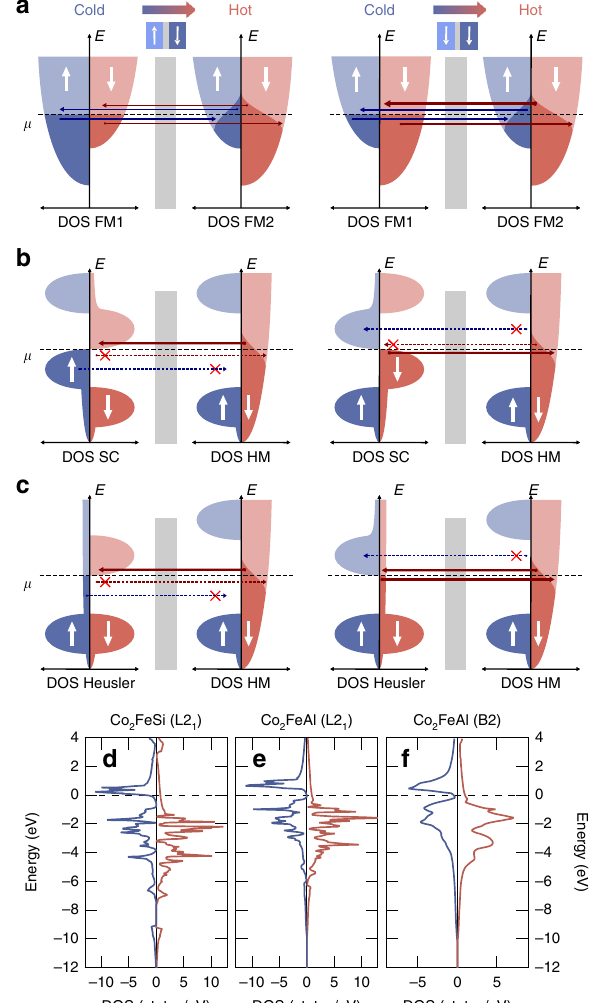
Fig. 1 In fl uence of the DOS. AP and P state. a , FM | FM. Since the individual currents cancel out, the Seebeck effect and TMS ratio are small. b , FMSC | HM. In the AP state electrons only travel above μ . In the P state electrons only travel below μ . This is optimal for generating large Seebeck coef fi cients with opposite sign. c , Heusler | HM. In the AP state the transport is similar to the FMSC | HM MTJ. In the P state electrons travel above and below μ . Hence, the Seebeck effect in the P state is small, while it is large in the AP state, leading to a large TMS ratio. d – f , The DOS